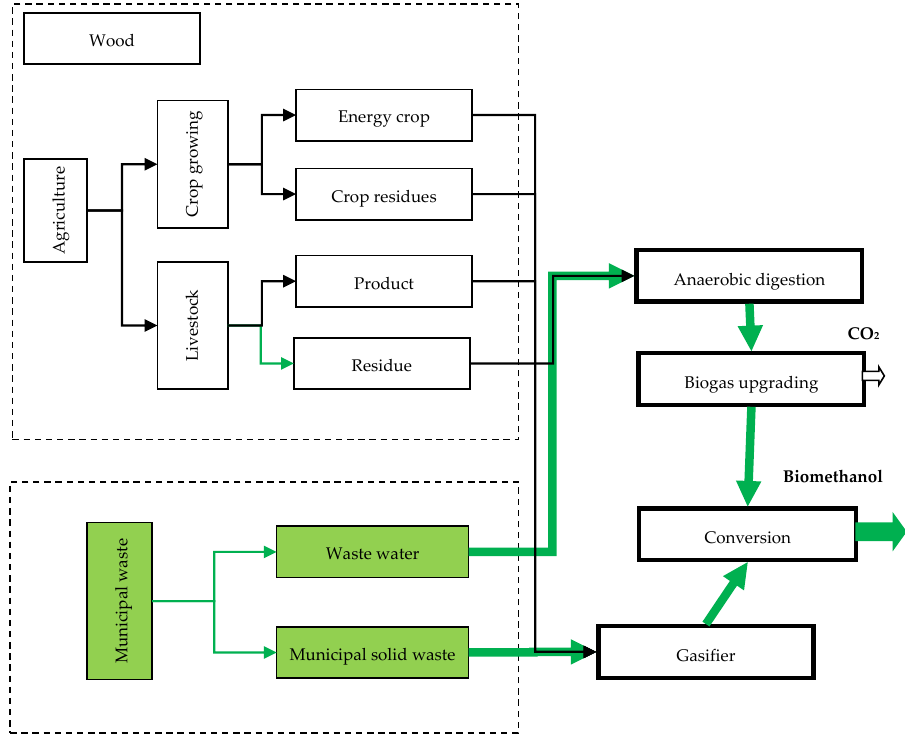
Figure 15. Biomethanol production.